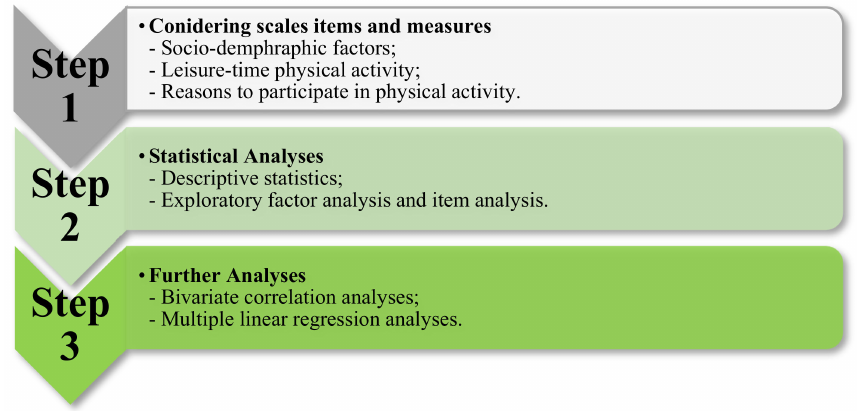
Figure 1. Scale development